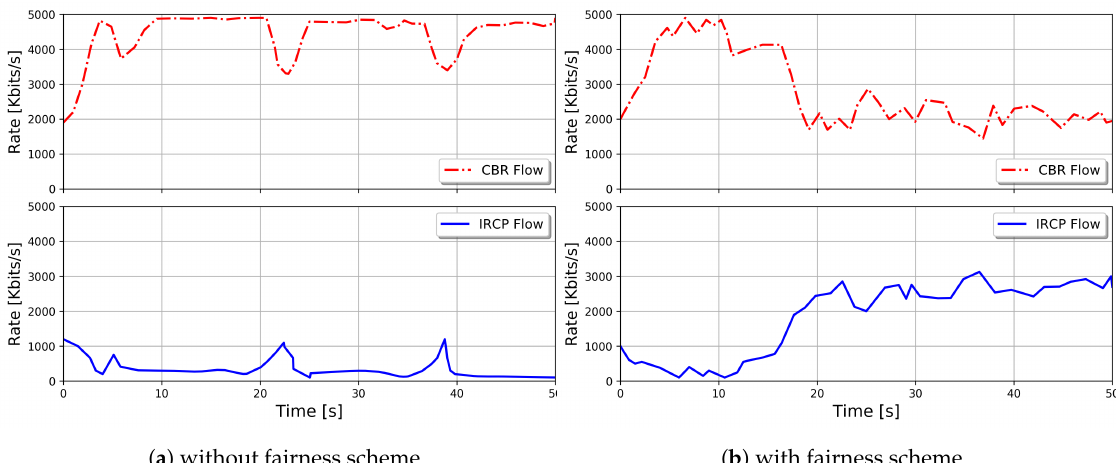
Figure 4. Data reception rates for CBR and IRCP flows.